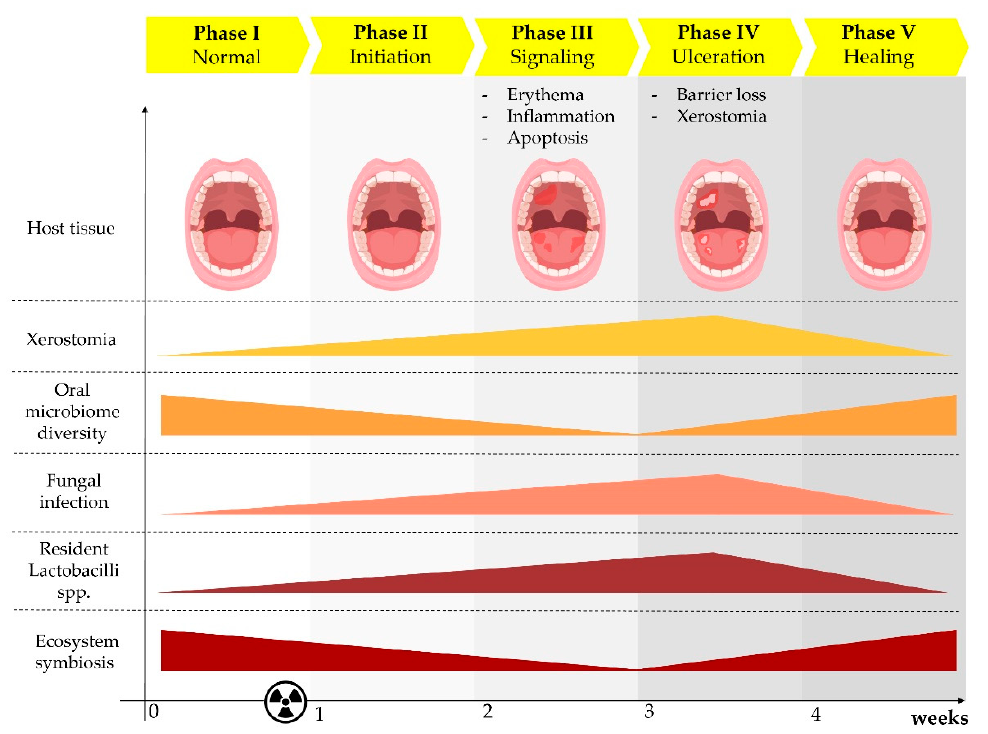
Figure 1. Radiation therapy (RT) induced multiple side effects during the oral mucositis (OM) stages. The clinical effects of RT in the host oral mucosa are highlighted in the upper panel (host tissue). Below, oral microbiome diversity is associated with reduced ecosystem symbiosis (dysbiosis) and the increased fungal infection occurrence. In parallel, the increase of Lactobacilli sp. is significantly high compared to healthy controls, when patients experience xerostomia. Novel studies reviewed here highlight the importance of more deep investigations to better explain the causality of these significant fluctuations for a more rational development of anti-inflammatory or antifungal therapies in OM.